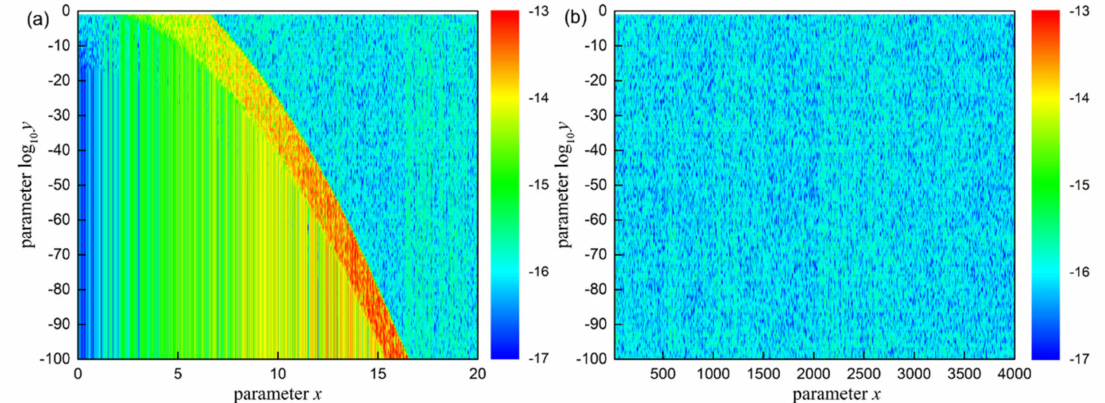
Figure 4. The logarithm of the relative error log 10 ∆ Re for the real part of the evaluation scheme (26) over the domain ( a ) 0 ≤ x ≤ 20 ∩ 10 − 100 ≤ y ≤ 0.1 and ( b ) 20 ≤ x ≤ 40,000 ∩ 10 − 100 ≤ y ≤ 0.1,